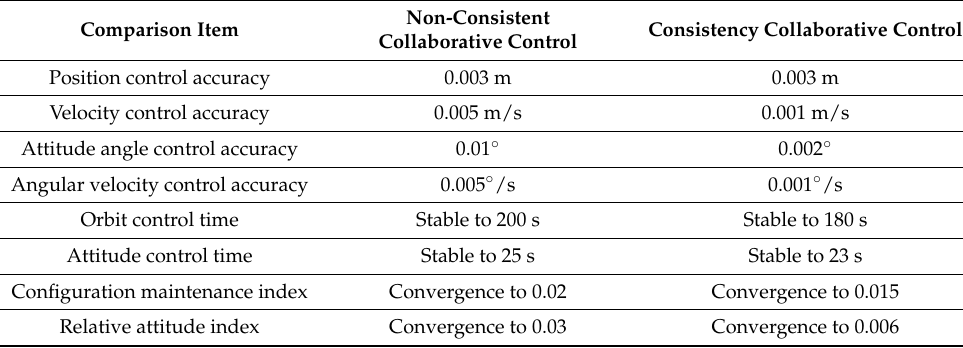
Table 2. Performance comparison of coordinated control with or without consistency. Comparison